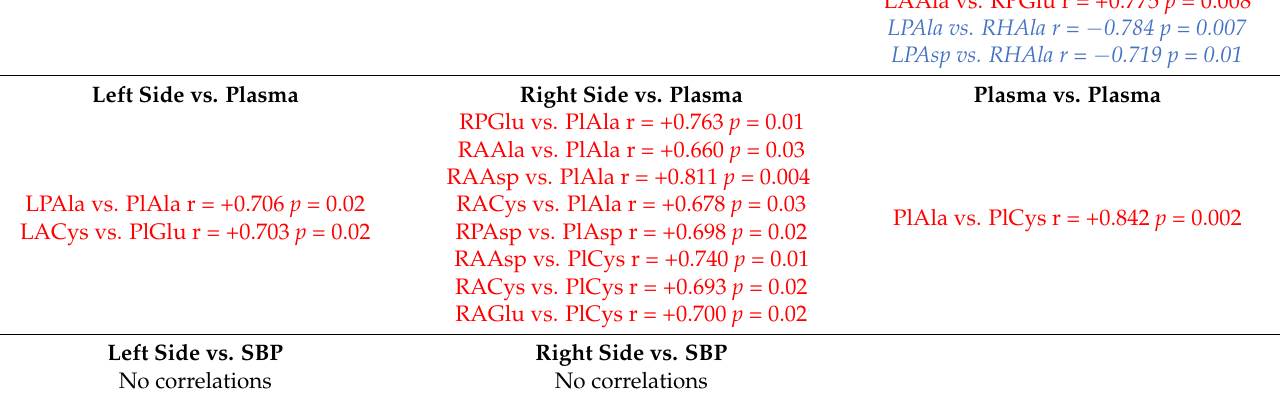
Left Side vs. Plasma Right Side vs. Plasma Plasma vs. Plasma